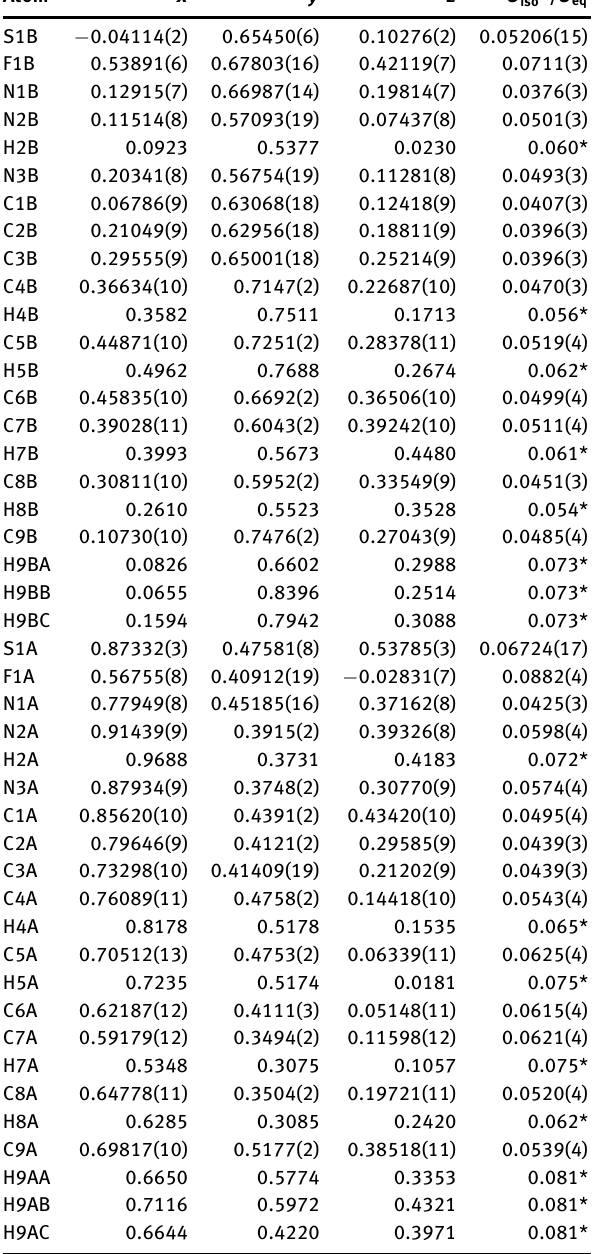
Table 2: Fractional atomic coordinates and isotropic or equivalent isotropic displacement parameters (Å 2